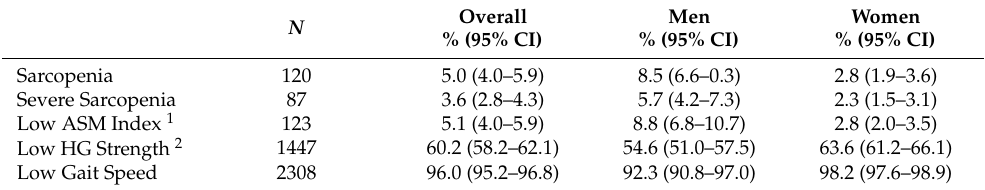
Table 2. Prevalence of Sarcopenia and its component status at baseline, overall and stratified by gender. N